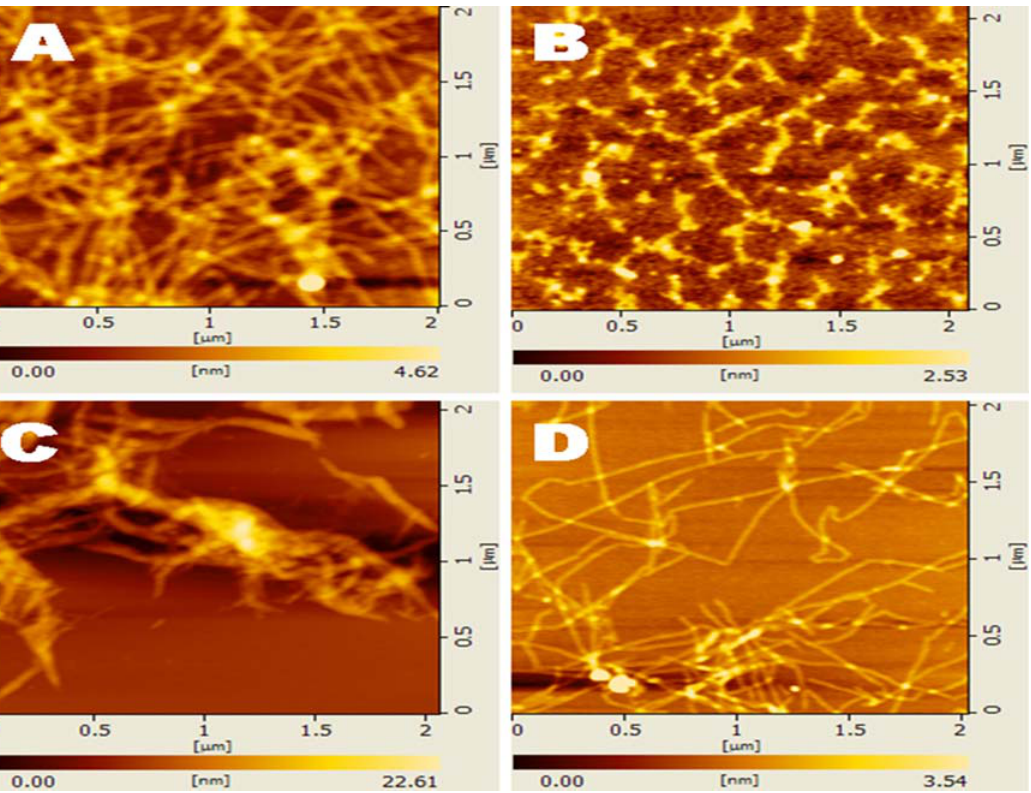
Figure 11. The AFM images of d-EAK16 (1 mg/ml, 0.1%) under salt and denaturation agents. A) 1 M NaCl, B) 1% SDS,C) 8.1 M urea, D) 7.1 M guanidine.HCl. d-EAK16 was incubated in the denaturation agents or salt overnight.